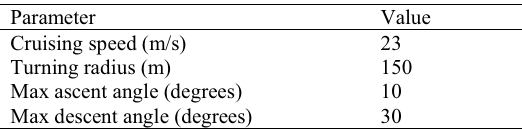
Table 2 . Flight properties of the UAV-autopilot system